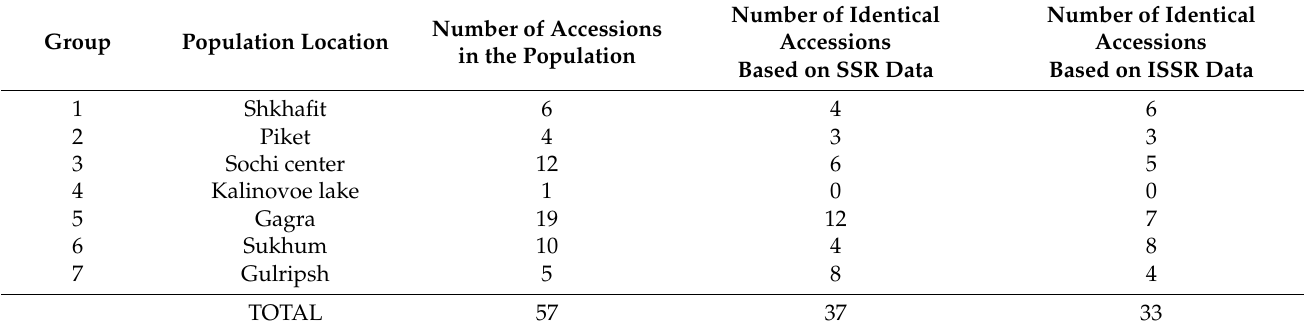
Table 3. Identical allelic pattern of D. lotus accessions based on ISSR and SSR